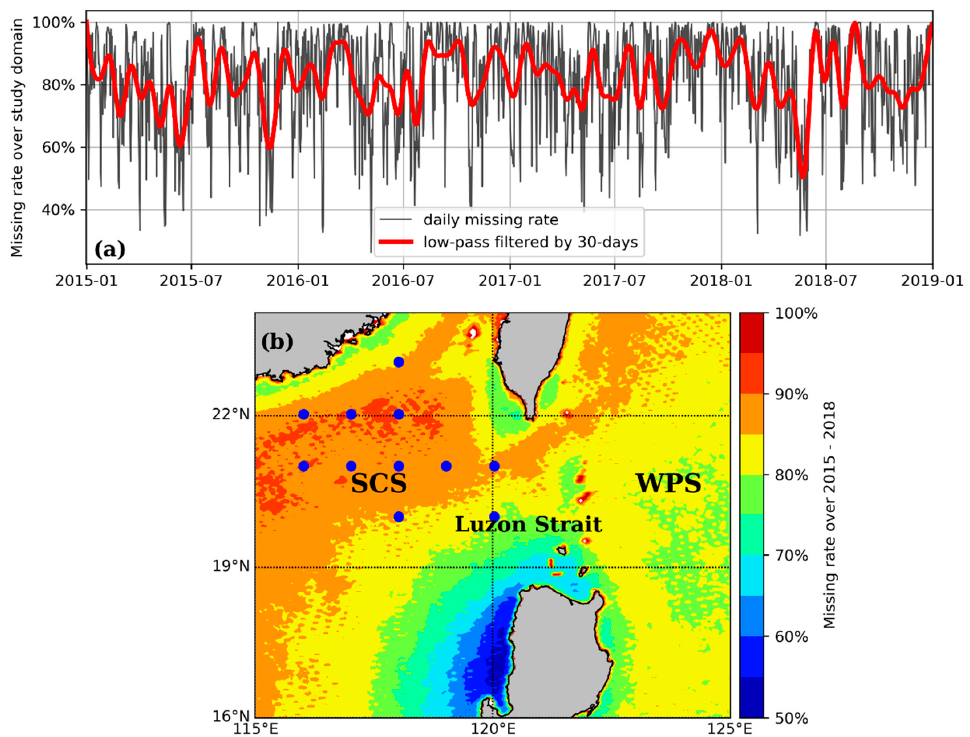
Figure 1. ( a ) Temporal variation of cloud cover percentage in the domain (in black) and with a low-pass filter of 30 days (red line); ( b ) mean percentage of cloud coverage for the complete set of images. SCS stands for South China Sea, and WPS stands for West Philippine Sea. The blue circles represent sampling stations.